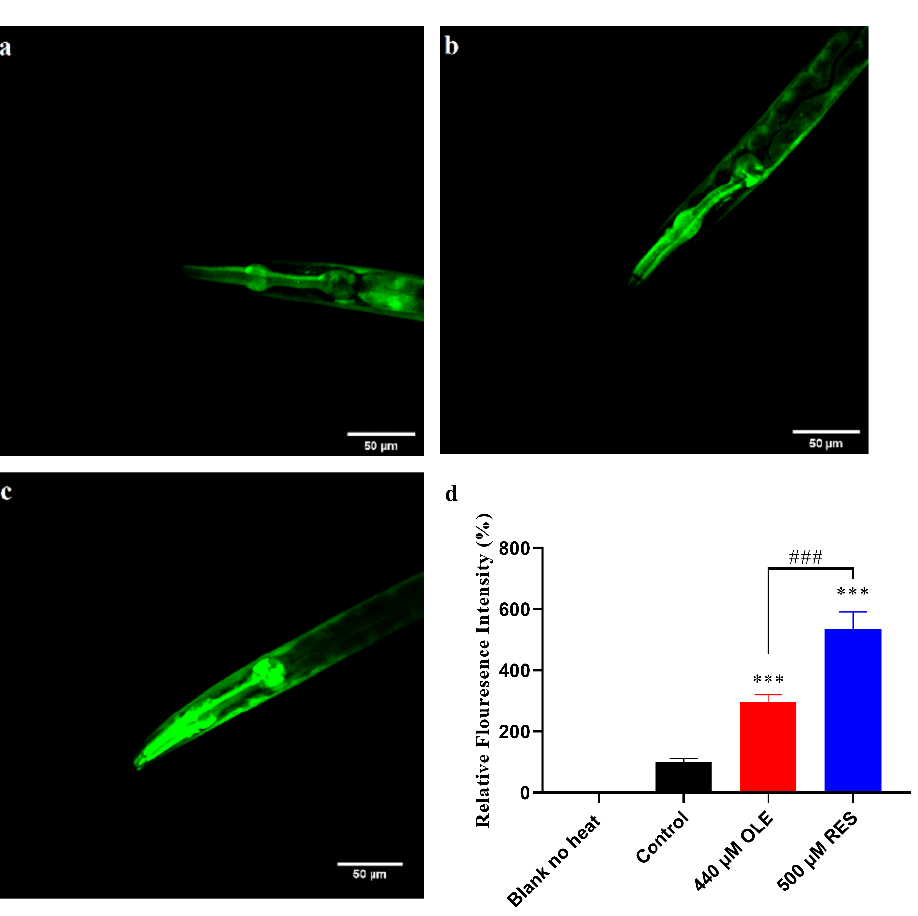
Figure 7. Effect of OLE on the expression of hsp-16.2 p::GFP under heat stress. ( a ) Control group; ( b ) OLE treatment group; ( c ) RES treatment group; ( d ) OLE significantly increased the expression of hsp-16.2 p::GFP. Data are presented as relative GFP intensity compared to the control. *** p < 0.001 suggests a significant difference when compared to the control group, while ### p < 0.001 suggests a significant difference when compared OLE with the RES group.